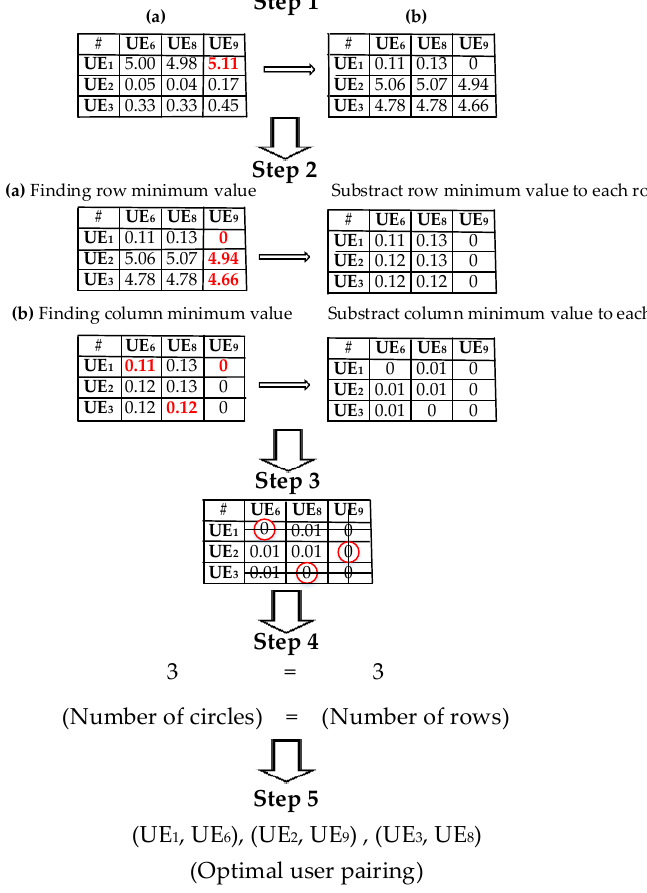
Figure 2. An example of user pairing process based Hungarian (HNG) algorithm for six users.